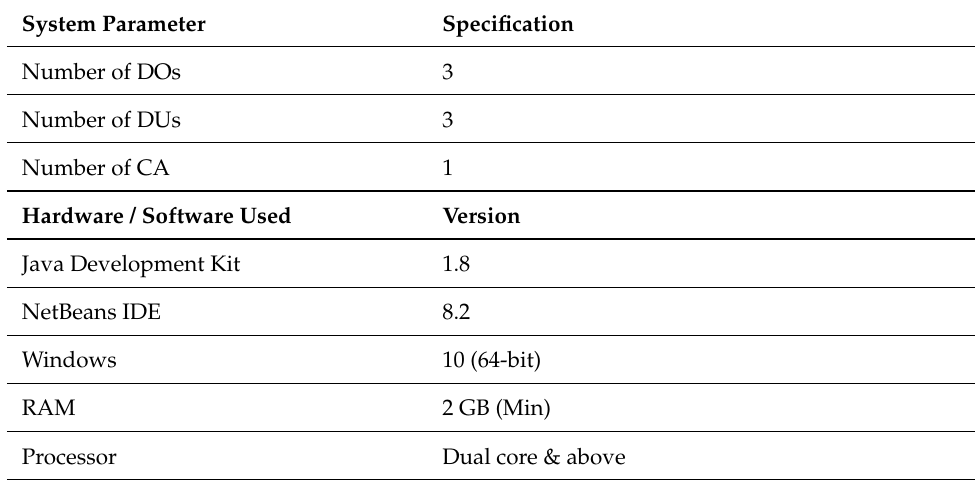
Table 2. Tools and